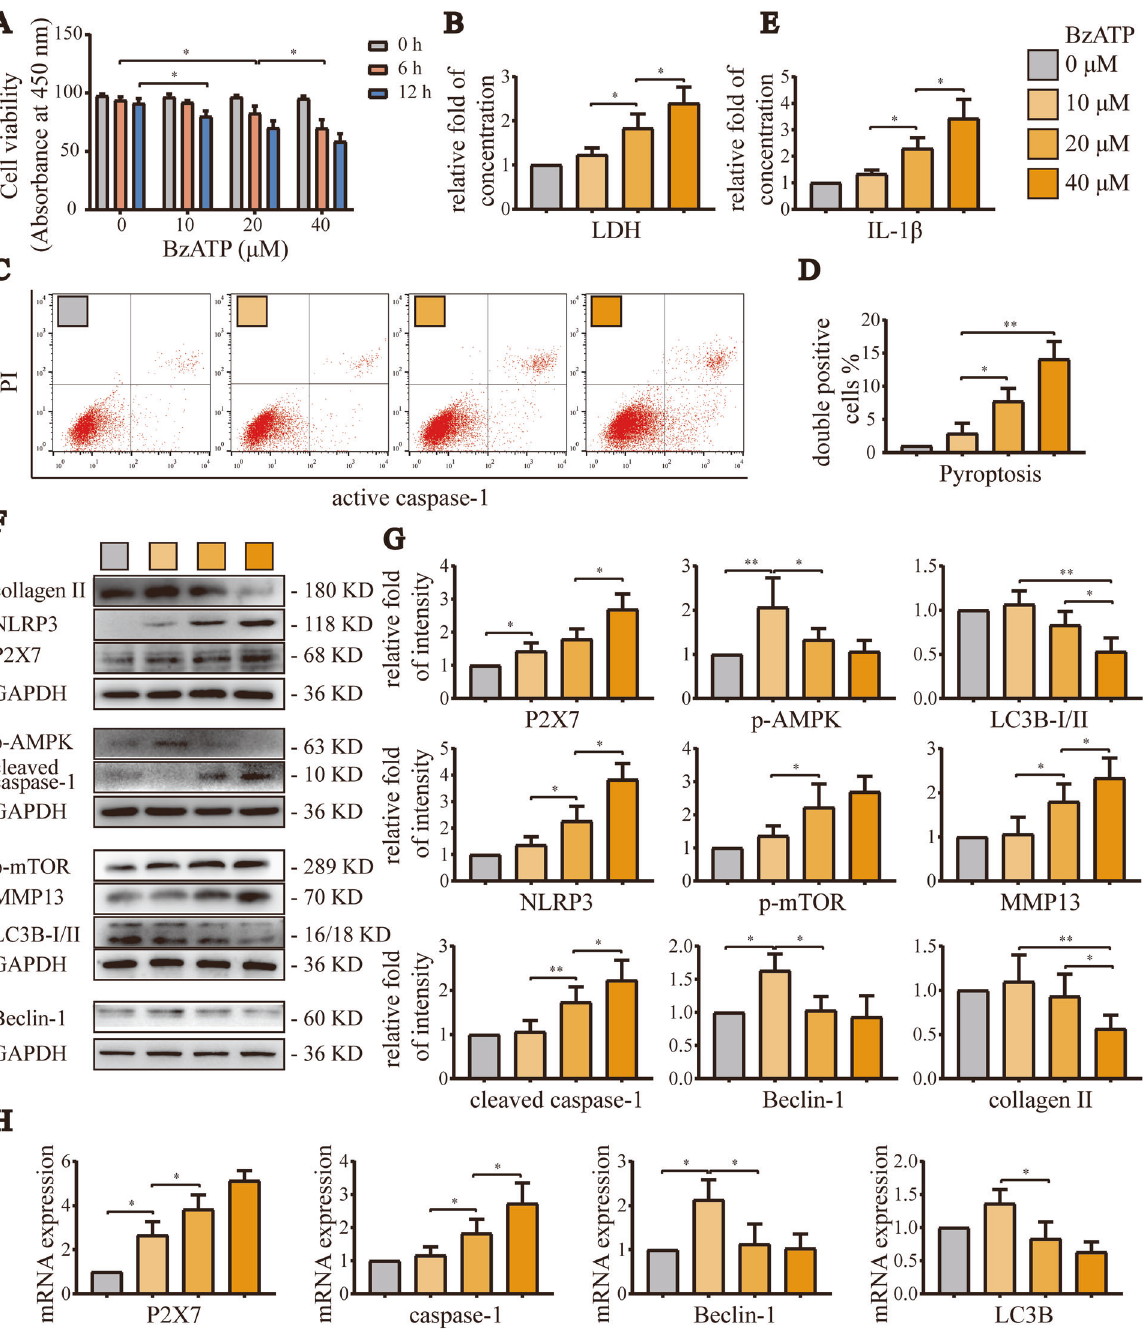
Fig. 4 Activation of P2X7 with increasing concentrations of BzATP fi rst promoted autophagy and then induced pyroptosis. A CCK-8 assays were used to evaluate cell viability in each group. Absorbance was measured at a wavelength of 450 nm. B LDH release assays were used to detect the degree of cell damage. C Flow cytometry was used to detect the number and ratio of caspase-1/PI-stained cells, re fl ecting the severity of cell pyroptosis. D Statistical data for stained cells. E ELISA was used to detect IL-1 β levels in cell culture supernatants from each group. F , G Western blotting and H RT-qPCR were used to detect protein and mRNA expression levels of P2X7, NLRP3, caspase-1, mTOR, AMPK, LC3B, Beclin-1, MMP13, and collagen II. Data are presented as means ± standard deviations of at least three independent experiments. * p < 0.05, ** p <